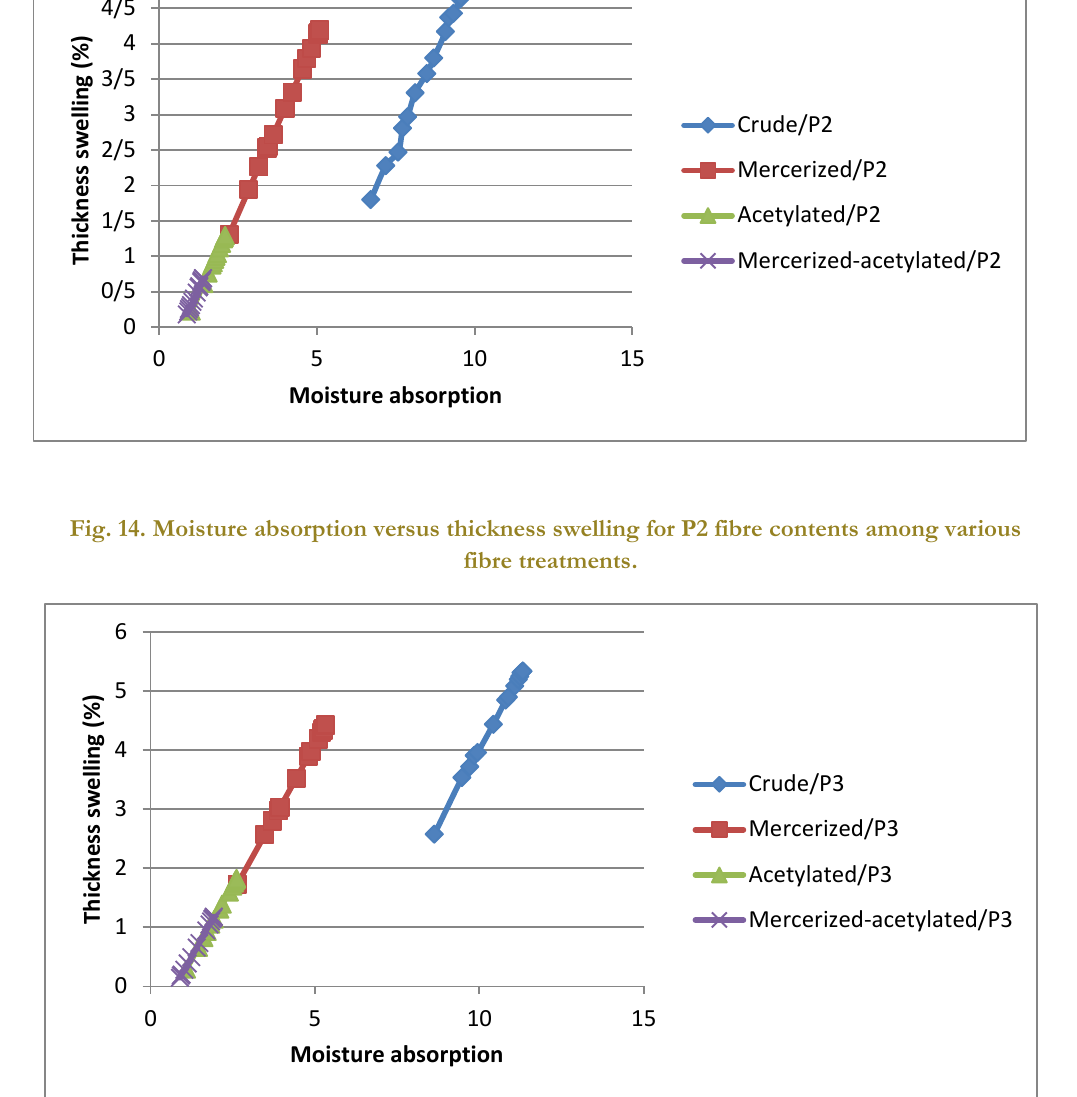
Fig. 15. Moisture absorption versus thickness swelling for P3 fibre contents among various fibre treatments.